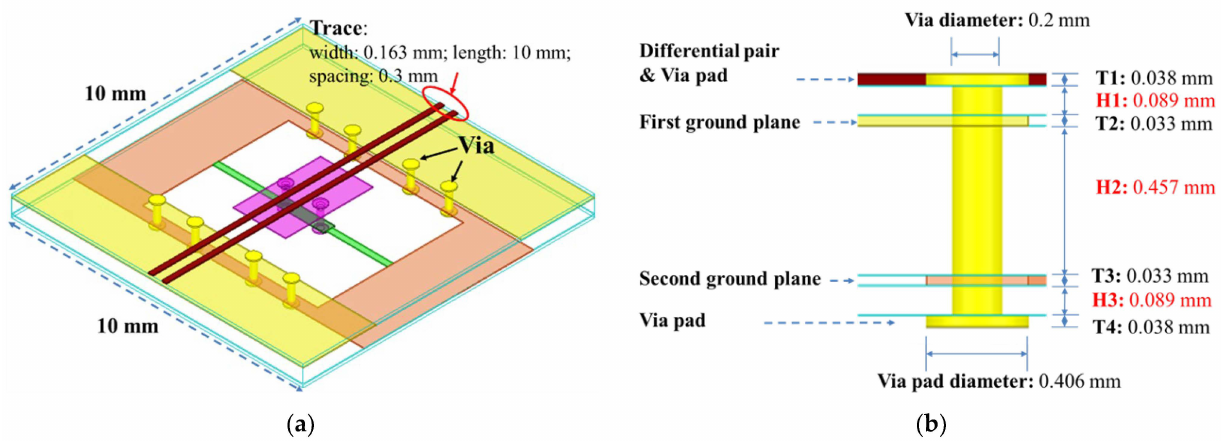
Figure 1. The proposed MDCRP filter structure. ( a ) Three-dimensional view. ( b ) Via side view. The first ground plane is shown in Figure 2a. It cuts a 5 mm × 10 mm slot to become the 2 ground sheets for GL1a and GL1b. The GL1a and GL1b of the ground sheet is connected to the second ground using four vias, respectively. There is a 3 mm × 1.8 mm vias to connect the second ground plane. The second ground plane is shown in Figure 2b.